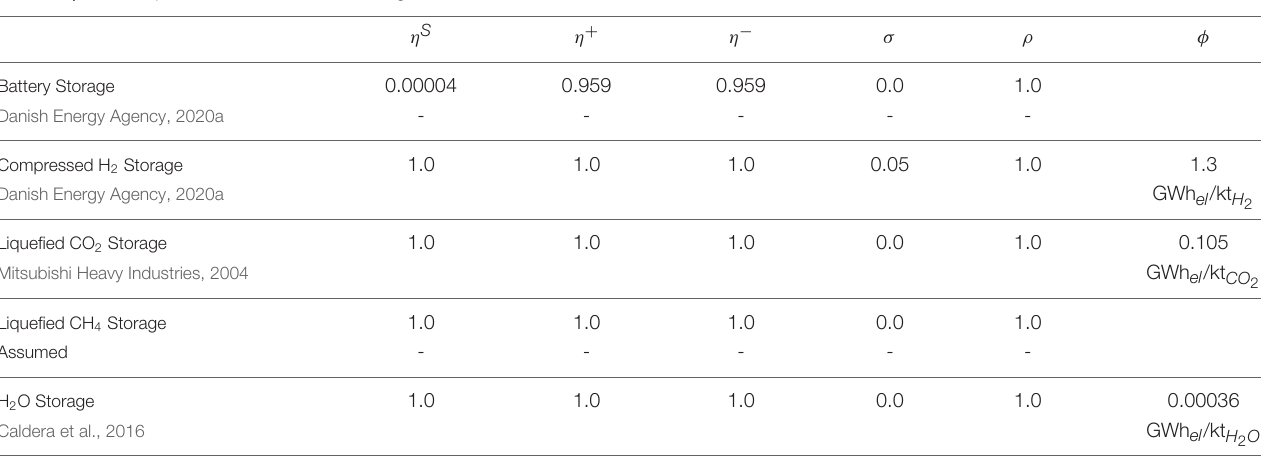
TABLE 3 | Technical parameters used to model storage nodes.